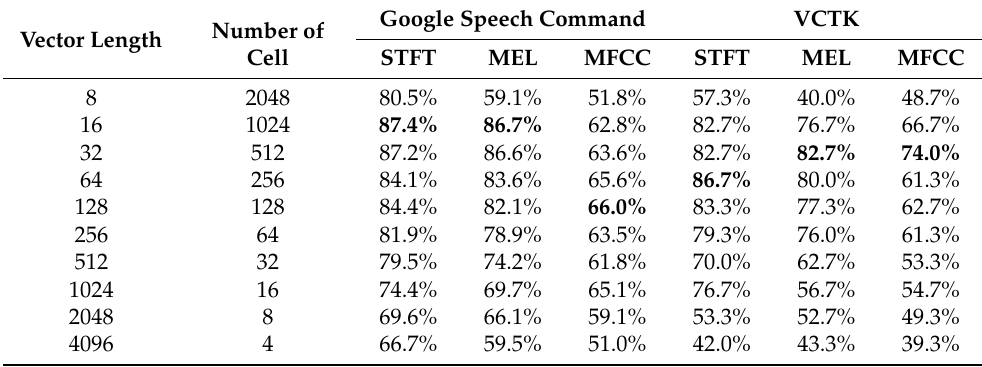
Table 3. Simulation result of speech datasets with 16 KB of